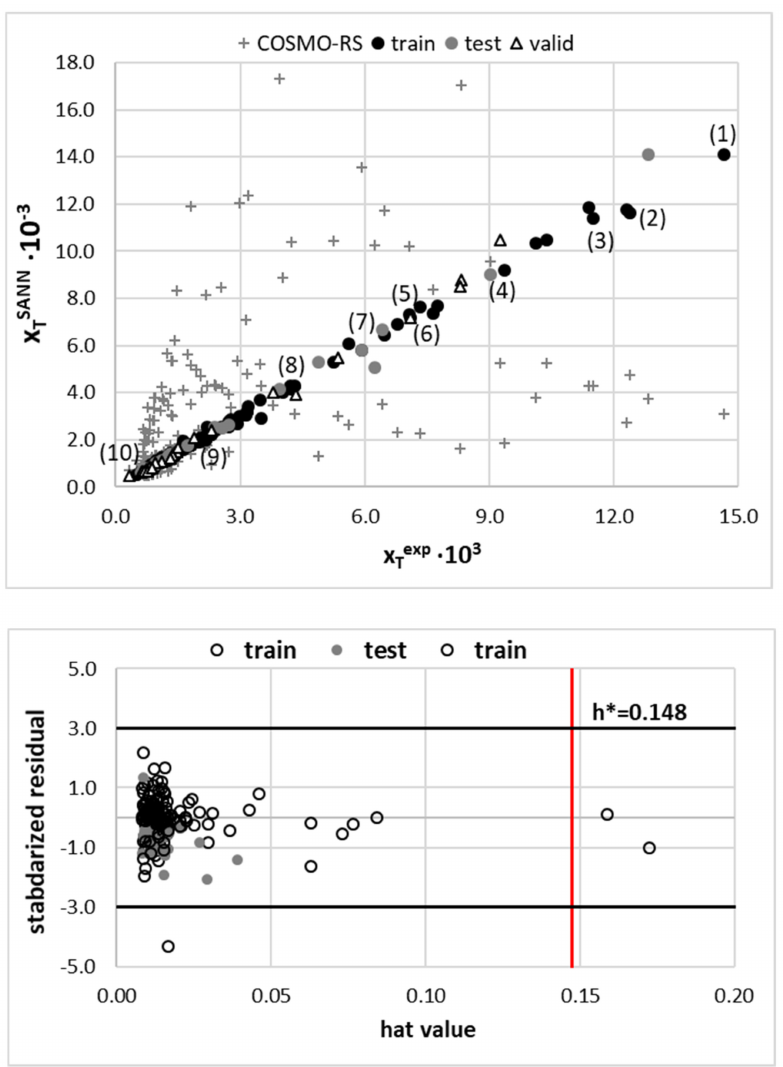
Figure 6. Accuracy of solubility prediction using COSMO-RS and an ensemble of SANNs, (top) relationship between experimental and predicted values of theophylline solubility in studied solvents and (bottom) applicability domain of a SANNs ensemble defined by relationship between standard- ized residuals and hat values. Some selected solvents were marked as (1) [ChCl+Glycerol+water] (0.8), (2) [ChCl+Sorbitol+water] (0.8), (3) [ChCl+Xylitol+water] (0.8), (4) [DMSO+water] (0.5), (5) [DMF+water] (0.5), (6) [DMSO], (7) [1,4-dioxane+water] 0.5, (8) 1-propoanol (9) acetone and (10)